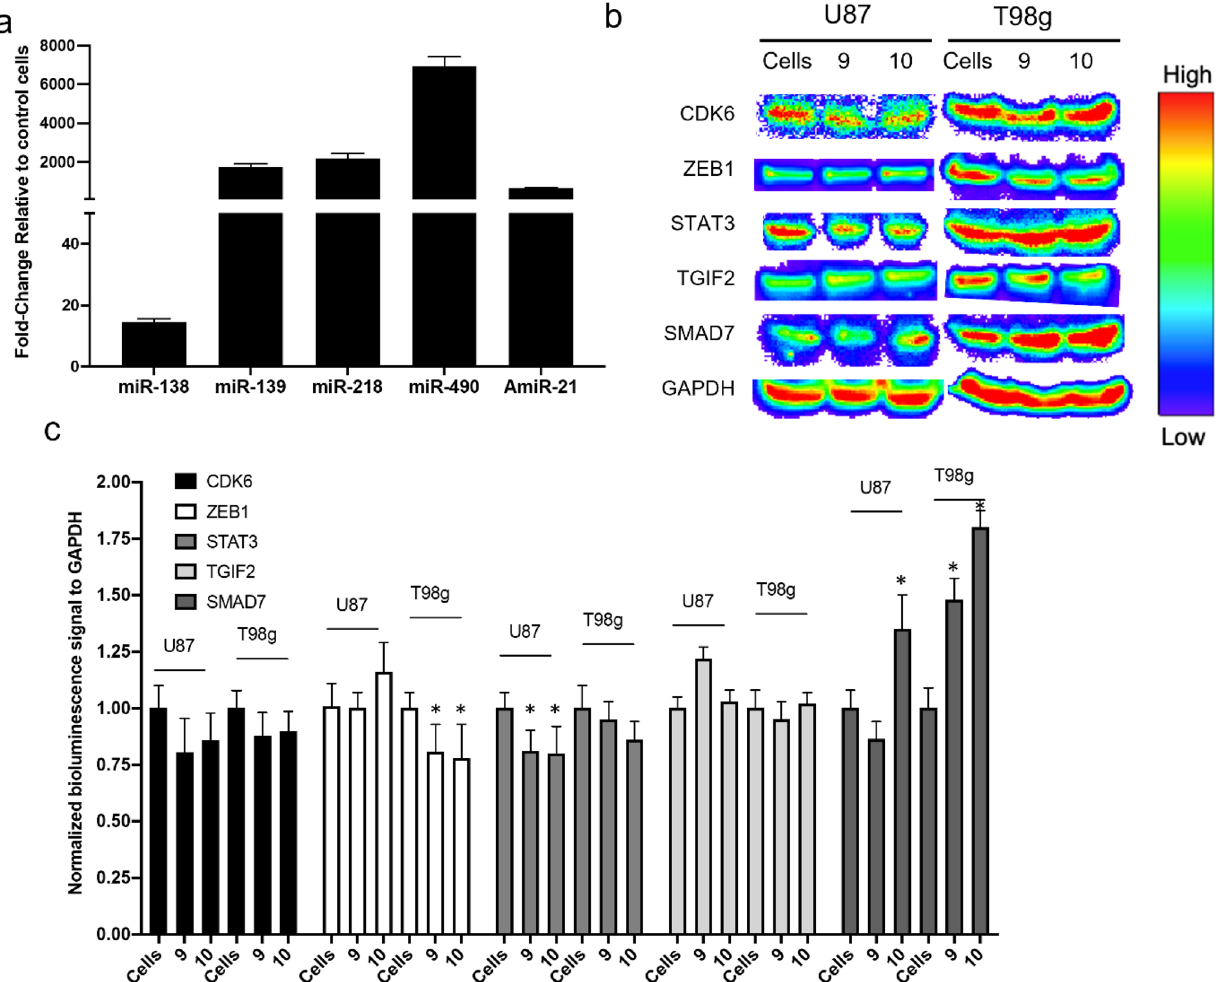
Figure 4. Effect of delivery of miRNAs to downstream target genes. ( a ) Quantitative PCR results showing in vitro delivery of miRNA loaded PLGA-PEG NPs to U87-MG cells. ( b ) Western blotting assays to show the effects of downstream mechanisms of the selected target genes. ( c ) Normalized bioluminescence signals from western blotting assays. The error bars represent the standard deviations of the data. Significance levels are shown in the right margins where, *represent p -value < 0.05. Asterisks show significant difference compared to control cells of the corresponding cell line. Cells = control cells without treatment, 9 = cells treated with condition #9, 10 = cell treated with condition